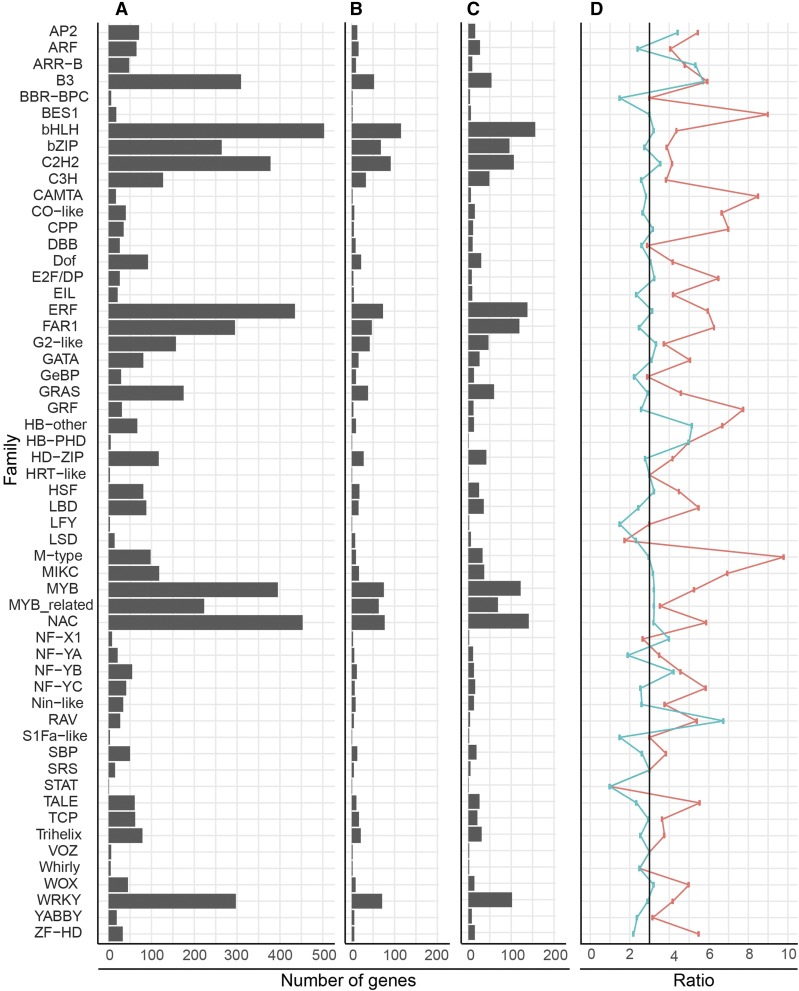
Comparison of genes identified per transcription factor family in wheat, barley, and rice. The number of genes in each family for (A) wheat, (B) barley, and (C) rice. (D) The ratio of wheat to barley (red) and wheat to rice (blue). In (D), the expected ratio (3:1) is indicated by a black line. Barley and rice data were obtained from PlantTFDBv3.0.